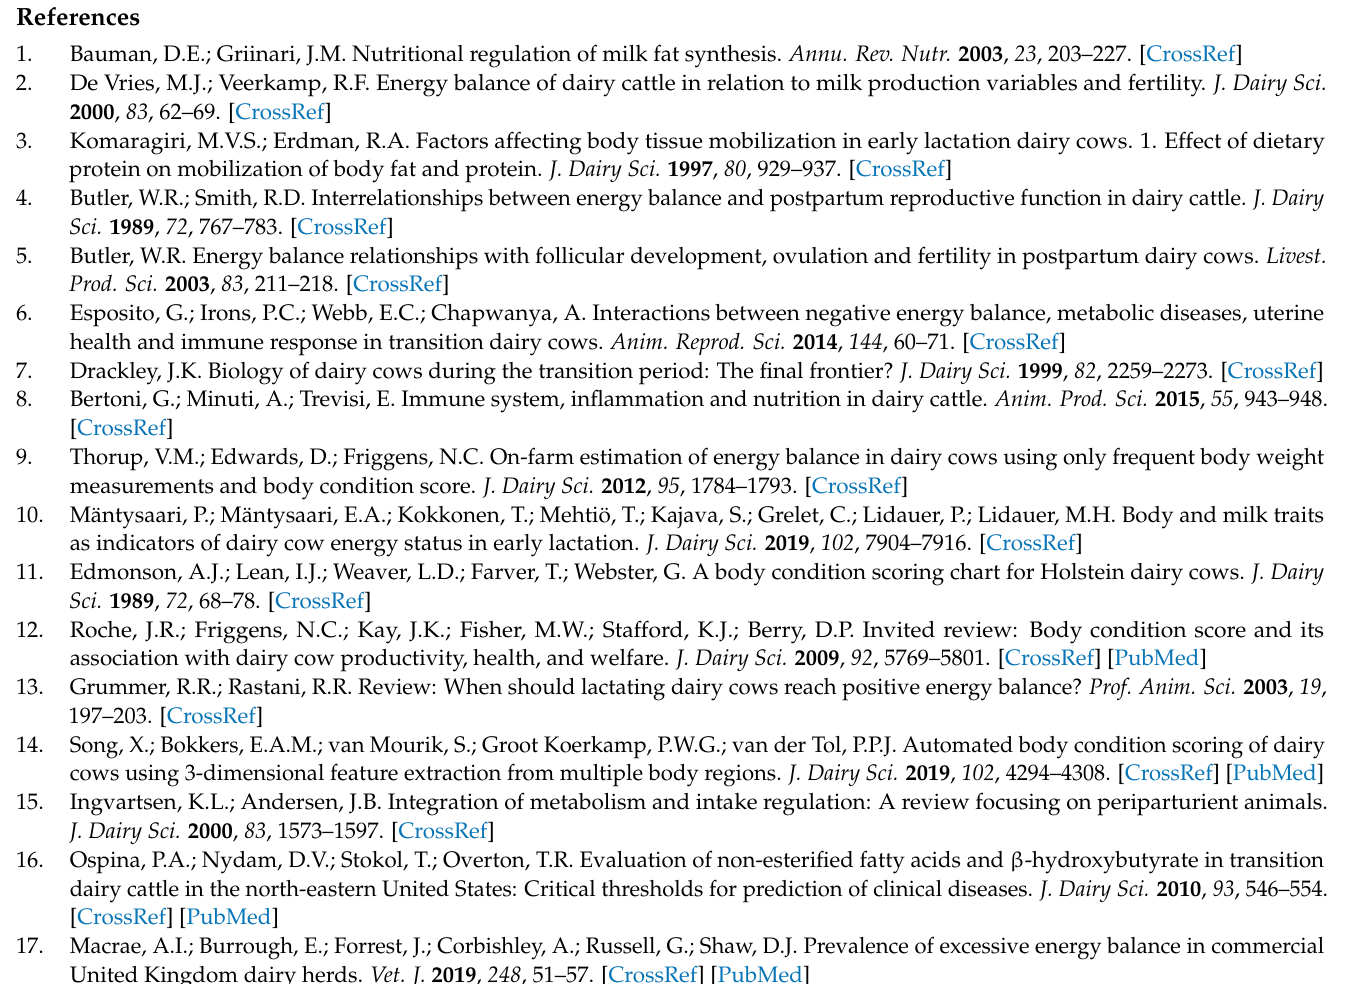
Figure A4. Linear relationships between fat-to-protein ratio in milk (FPR) and daily energy balance (EB, MJ of ME/day) in ≥ fourth lactation Holstein-Friesian dairy cows (1–20 WIM). Mixed regression models for each relationship are presented in Table